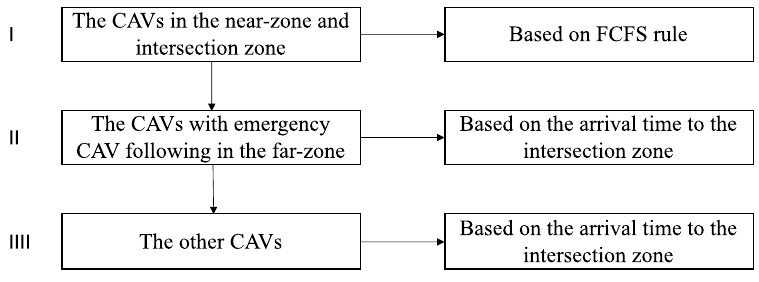
Figure 4. Priority